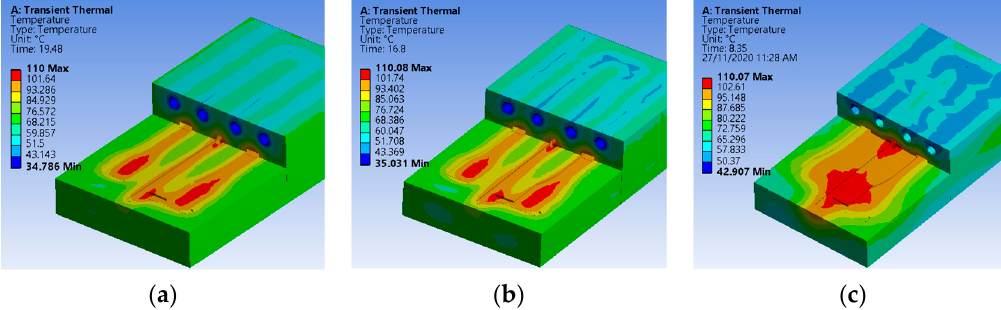
Figure 11. Result of transient thermal analysis: ( a ) EB mold insert; ( b ) EC mold insert; ( c ) P20 mold insert. Table 9. Result of cooling time.